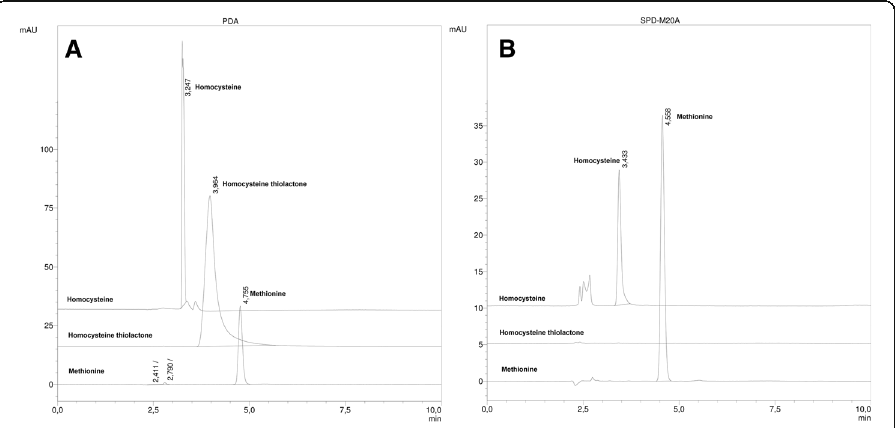
Fig. 2 Chromatograms with the EP conditions for the reference solutions at UV 225 nm: a ) Mancherey & Nagel (MN) column b ) Phenomenex (PH) column